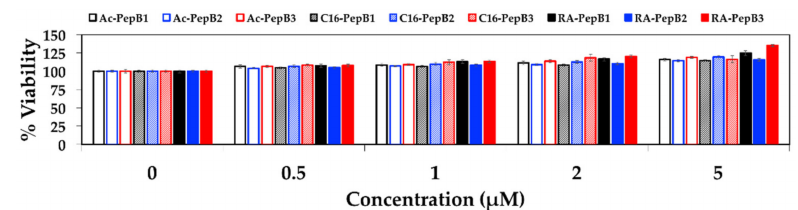
Figure 5. ReNcell VM (RVM, from ventral mesencephalon) cell viability measured with WST-8 after 24 h of treatment with varying concentrations and repeats of Ac-PepB, C16-PepB, and RA-PepB. N = 12; error bars depicted as standard error of the mean (SEM).